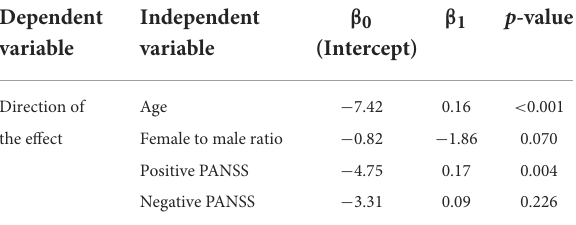
TABLE 3 Results of the logistic meta-regression analyses for investigating the possible causes of